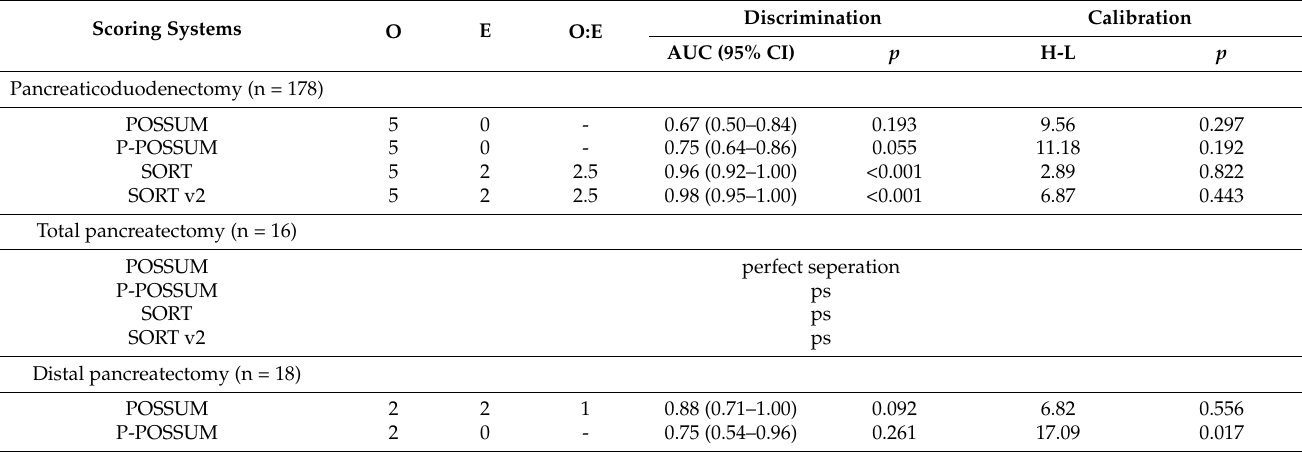
Figure 2. Receiver Operating Characteristic (ROC) curves regarding the discrimination of each model in the total study population. ROC curves regarding. ( a ). Surgical Outcome Risk Tool (SORT), ( b ). SORT v2, ( c ). Physiological and Operative Severity Score (POSSUM), ( d ). Portsmouth-POSSUM (P-POSSUM). Table 3. Discrimination and calibration traits of each score for predicting mortality in certain